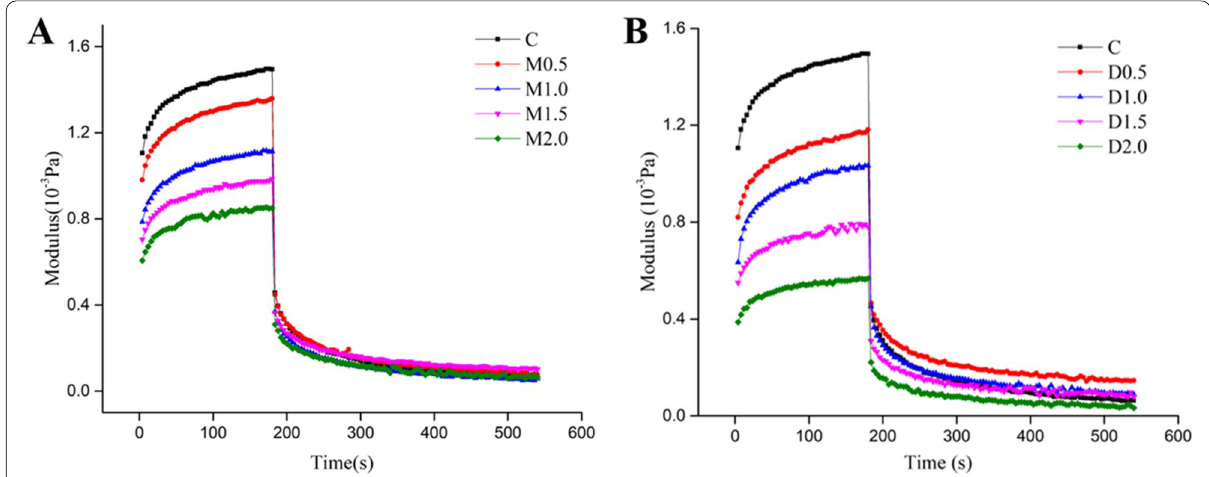
Fig. 2 Creep-recovery curves of the composite MP gel with modified starch ( A ) and dietary fiber ( B )